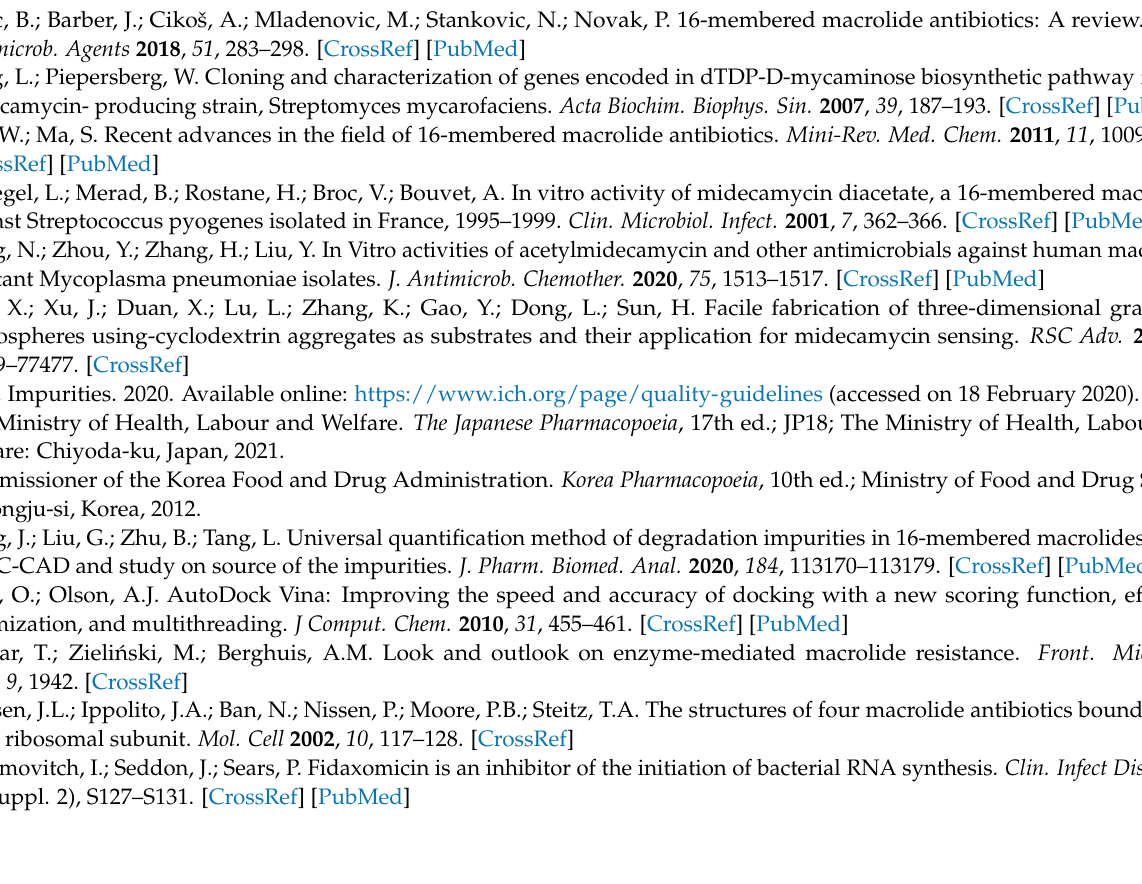
Figure S1. MS 2 spectrums of the impurities; Figure S2. The UV spectrums of the impurities; Figure S3. The 3D docking images of the components (or